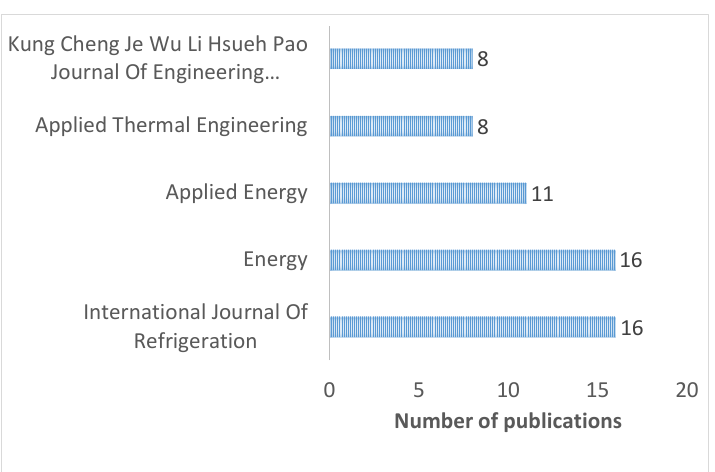
Figure 4. Top journals selected by researchers. The top countries/territories that are publishing on the topic is published is shown in Figure 5. China and Europe (EU27) are leading the research with the almost same trend